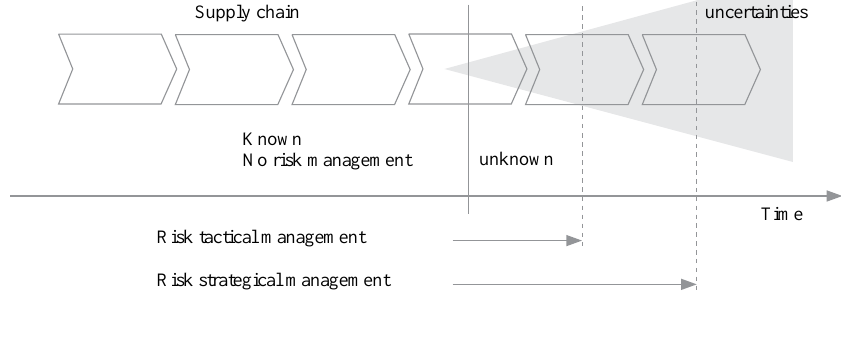
Fig. 1. Risk management